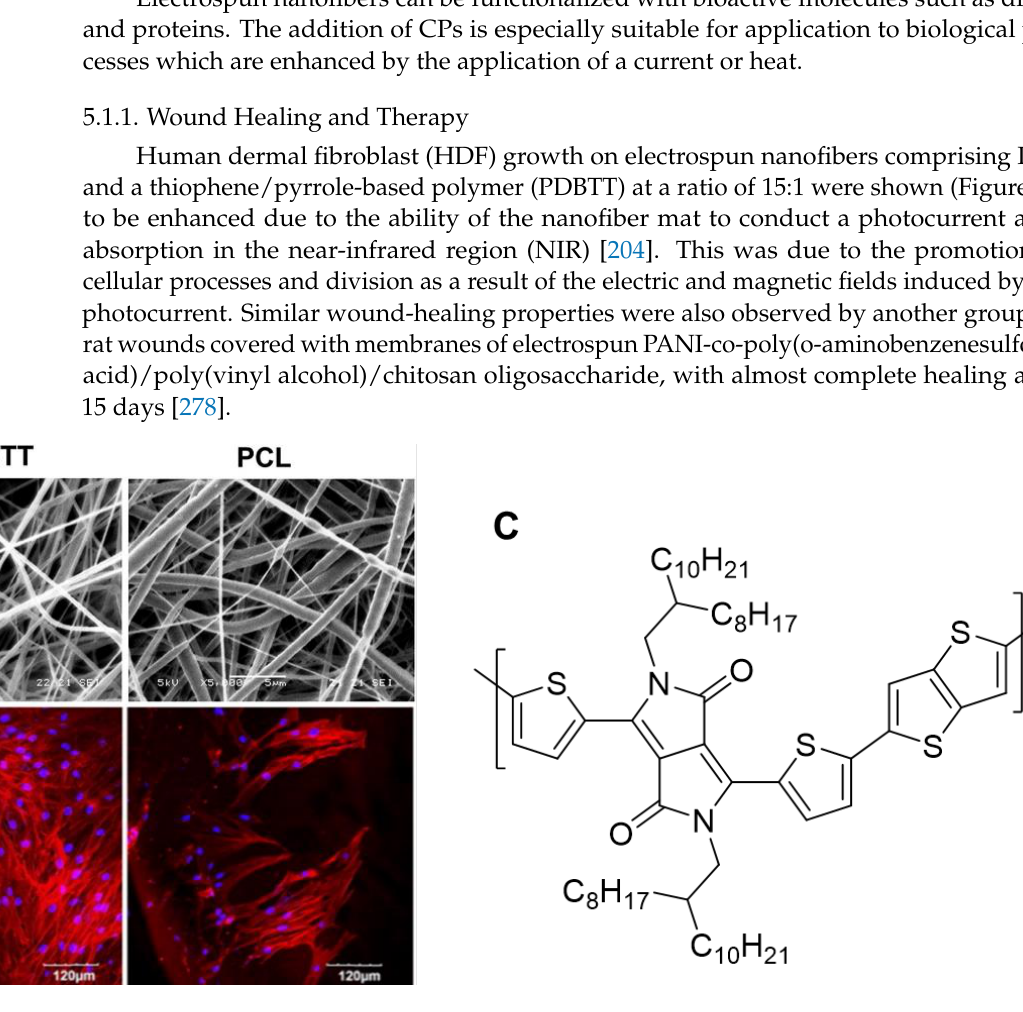
Figure 15. Wound healing application of electrospun CPs [204]: ( A ) SEM images of electrospun PCL/PDBTT and PCL nanofibers; ( B ) confocal and SEM images of extent of growth of HDF on electrospun PCL/PDBTT and PCL nanofibers, showing enhanced HDF growth on PCL/PDBTT with light stimulation; ( C ) structure of thiophene/pyrrole-basedpolymer PDBTT. Reprinted with permission from Ref. [204]. Copyright 2017, with permission from Elsevier.